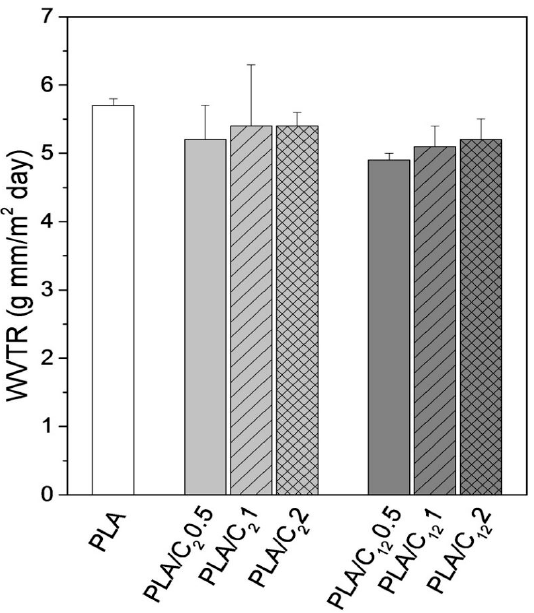
Figure 22. Water vapor transmission rates (WVTRs) of PLA films and PLA nanocomposites incorporated with nanochitin modified by acetic anhydride (C2) and fatty aliphatic chains (C12) [57].